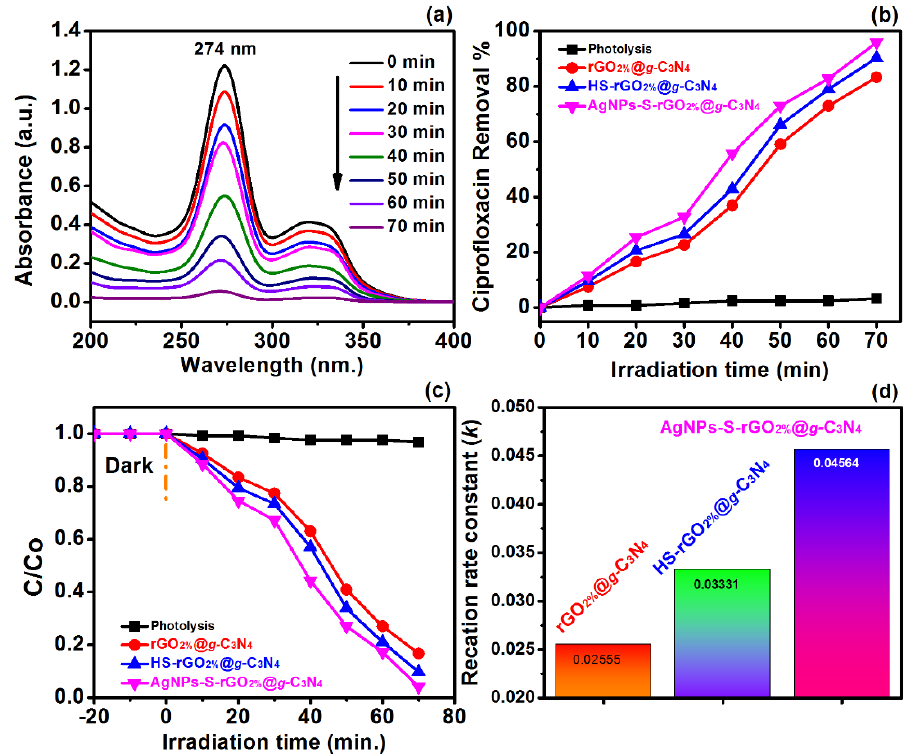
Figure 13. ( a ) UV-Absorption spectra of CIP ( b ) percentage removal of CIP with and without a catalyst ( c , d ) reaction rate constant for CIP degradation.